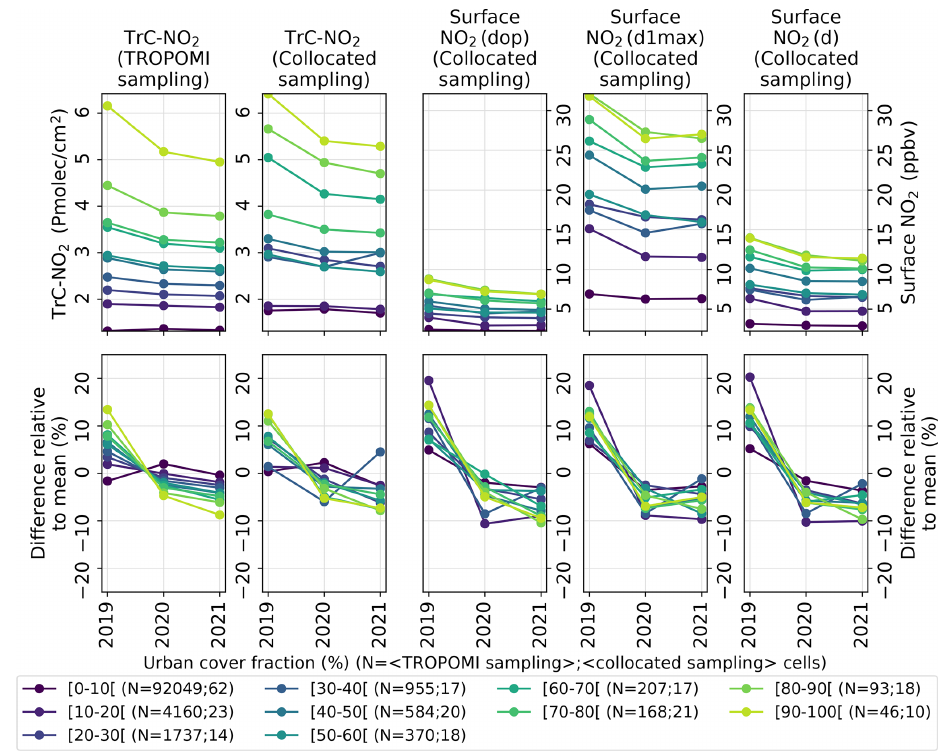
Figure 11. Mean annual profiles (top panels) and differences relative to multi-annual mean (bottom panels) for different levels of urban cover fraction, considering the TROPOMI TrC-NO 2 full dataset (left panels) and TROPOMI TrC-NO 2 collocated with surface stations (right panels). The collocation of TROPOMI-based and surface-based observations is here performed both spatially and temporally (on a daily basis); the corresponding numbers of cells (averaged over the different months of the year) are indicated in the legend. Crops cover fractions are here binned in bins of